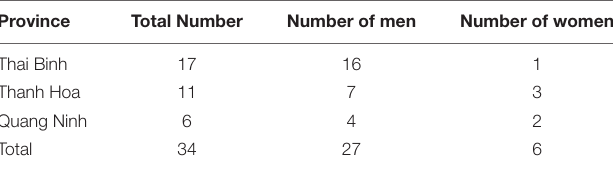
TABLE 2 | Numbers of key informant interviewees in the study sites.